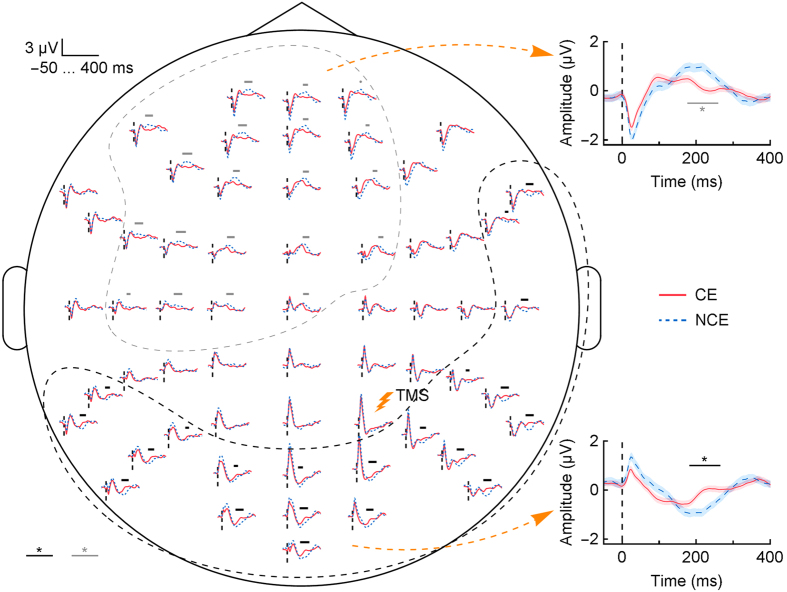
TMS-evoked EEG responses.The responses averaged across participants and plotted over a scalp map of the electrode positions. The black and gray bars indicate the channels and time points belonging to two clusters with significant differences between the CE (red) and NCE (blue) conditions [P = 0.042 for the anterior cluster and P = 0.031 for the posterior cluster]. The insets show the responses further averaged across the channels belonging to the clusters (indicated by the dashed lines); the horizontal bars mark significant differences between the CE and NCE conditions. The shaded areas represent mean ± standard error. The vertical dashed lines depict the moment of TMS. *Indicates P < 0.05. CE = conscious experience, NCE = no conscious experience.